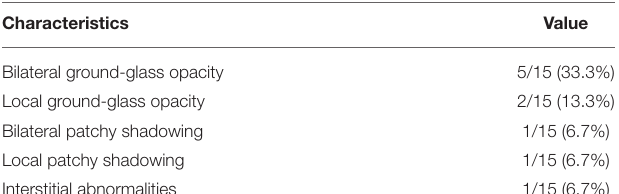
TABLE 3 | Changes on the computed tomography of breast cancer patients with COVID-19.